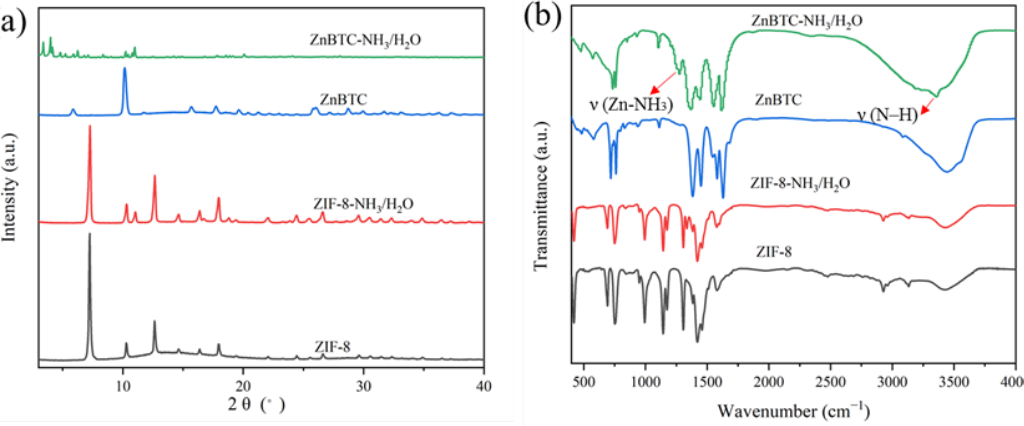
Figure 4. NH 3 adsorption and desorption curves obtained for ZnBTC and ZIF-8. To further demonstrate the application of the MOFs for the absorption of NH 3 , ad- sorption experiments were also carried out under ammonia water during the composting process. The adsorption performance during the thermophilic phases during aerobic com- posting was defined as ZIF-8-1 and ZnBTC-1. ZIF-8-2 and ZnBTC-2 represent the adsorp- tion performance under a 25% NH 3 solution steam atmosphere. ZIF-8-3 and ZnBTC-3